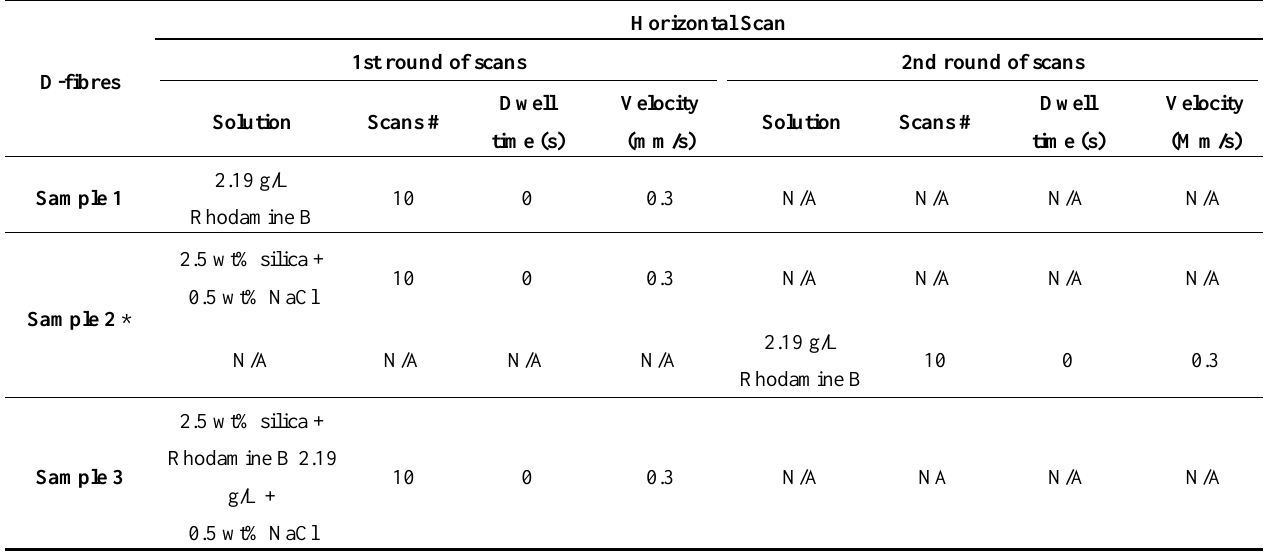
Table 2. Summary of the conditions of the experiments and solutions used.